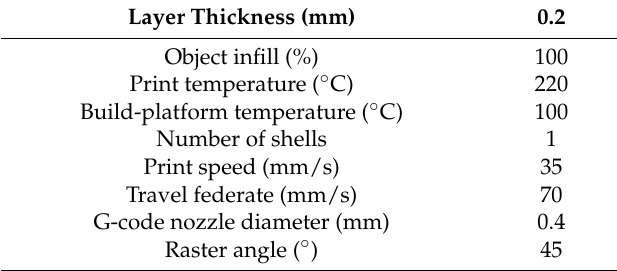
Table 2. List of 3D printing process parameters of PP/SEBS